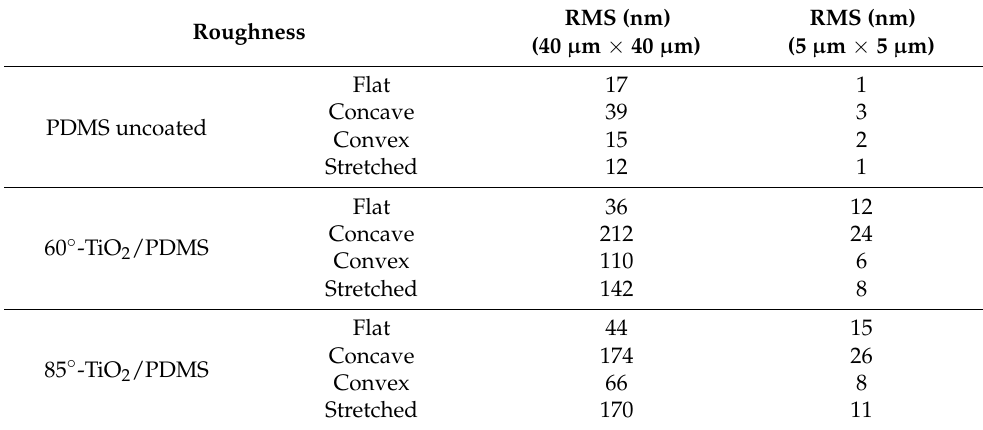
Figure 2. AFM images of PDMS and 85° ‐ TiO 2 /PDMS surfaces in flat (after a single bending event, ( a1 , a2 ), stretched ( d1 , d2 ) and bent configurations, this latter in the form of either a concave ( b1 , b2 ) or a convex ( c1 , c2 ) surface, respectively. Table 1. RMS roughness values at two different scales determined from AFM for PDMS and pat ‐ terned 60° ‐ TiO 2 /PDMS and 85° ‐ TiO 2 /PDMS samples in flat (after a single bending event), concave, convex and stretched configurations.